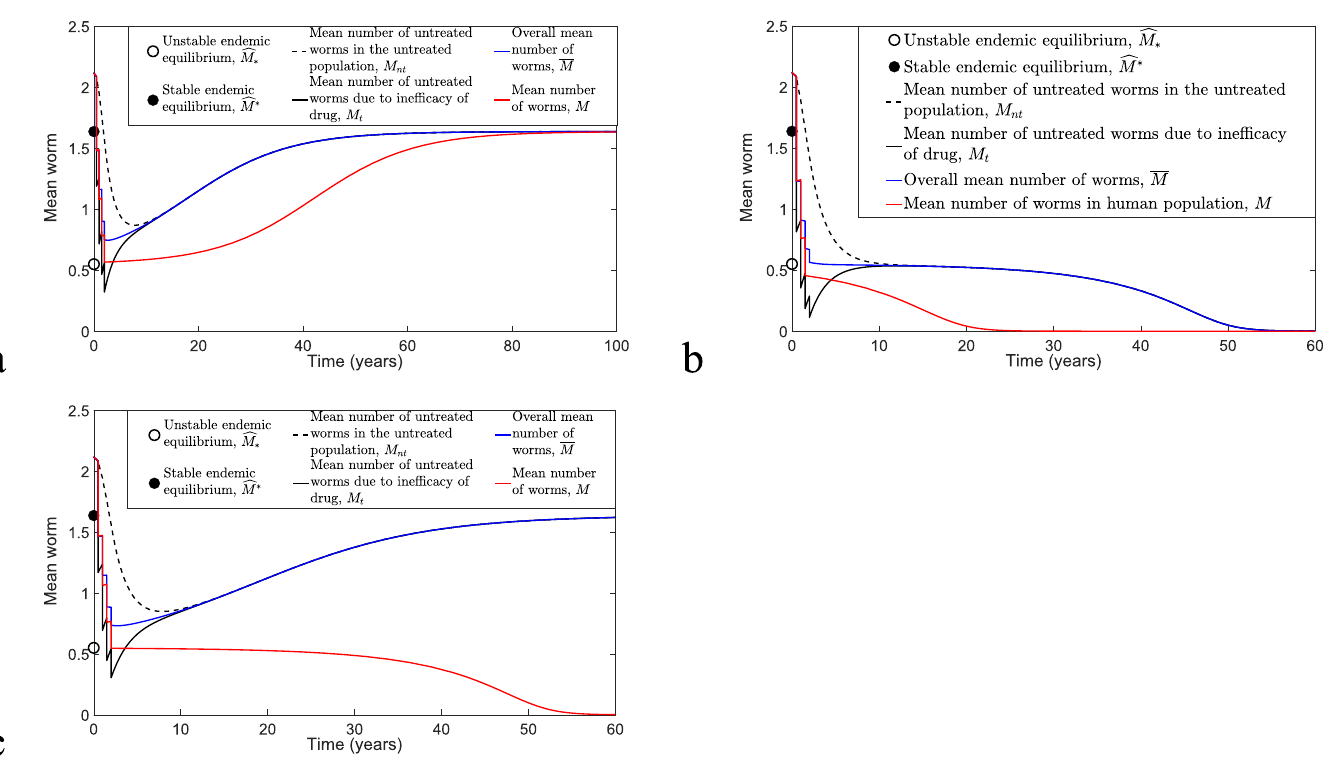
Fig 10. Numerical results of model (3) and (4) and model (9) and (10) by varying � and applying the coverage of MDA data from the TUMIKIA community-based biannual deworming control strategy. (a) Disease persistence if � < 0.44. (b) Disease extinction is possible if � � 0.61. (c) Disease extinction is possible for model (3) and (4) if � � 0.44, but the disease will remain in endemic state for model (9) and (10) if � <